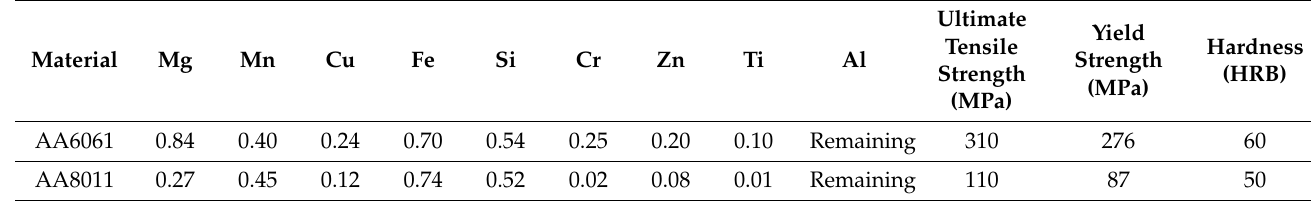
Table 1. Chemical patterns showing wt.% and MP values for AA6061 and AA8011